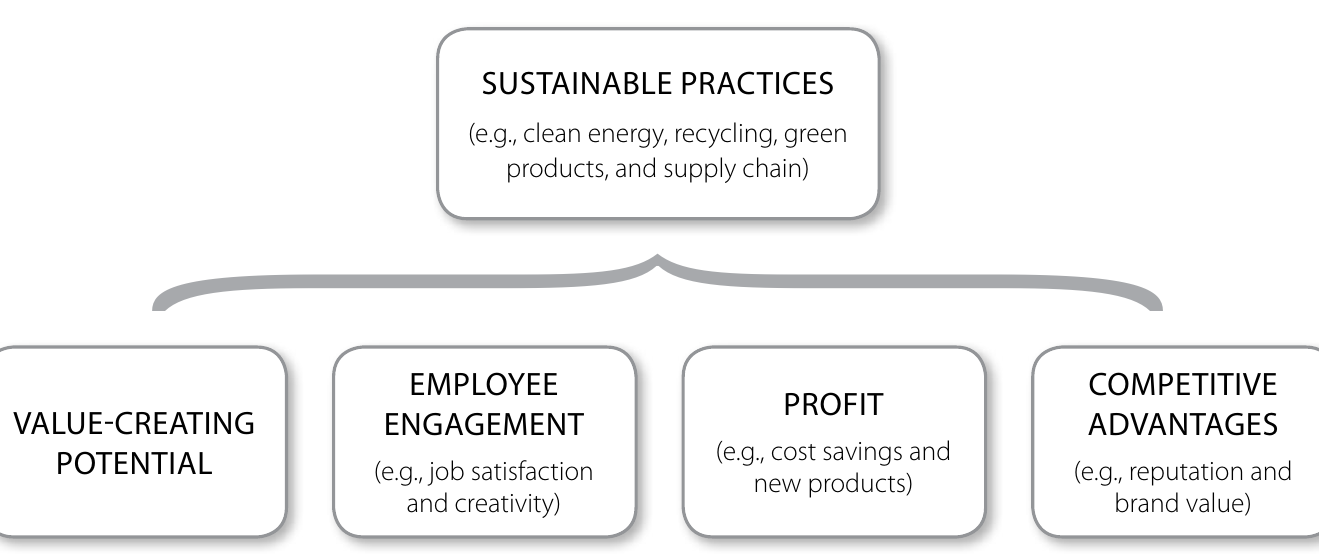
SUSTAINABLE PRACTICES (e.g., clean energy, recycling, green products, and supply